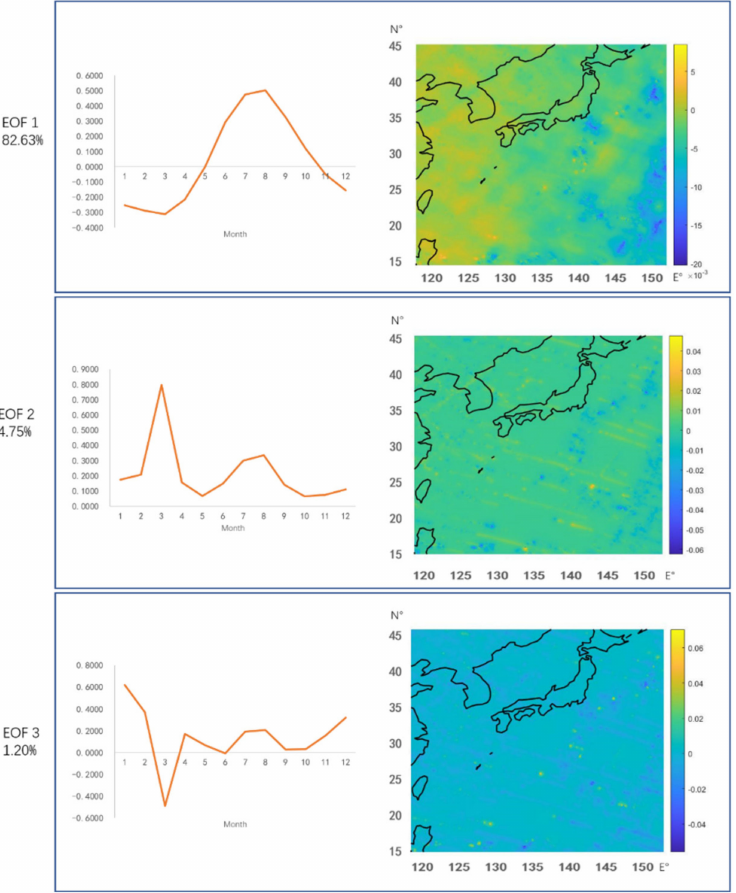
Figure 5. Three kinds of variance contribution rate of EOF Modes of time ( left ) and space ( right ) (The line chart on the left represents the time series corresponding to the study area, and the color chart on the right represents the spatial modes corresponding to the study